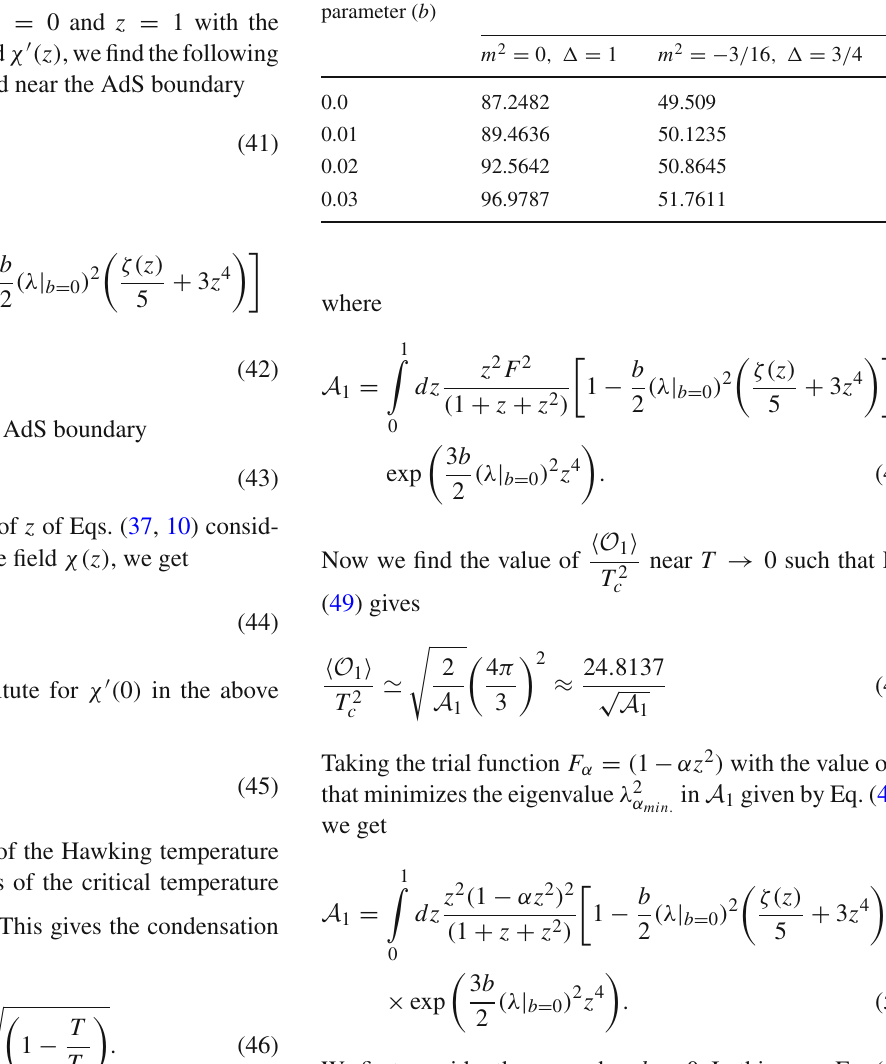
Table 2 Condensation operator value for different values of BI param- eter Born–Infeld parameter ( b